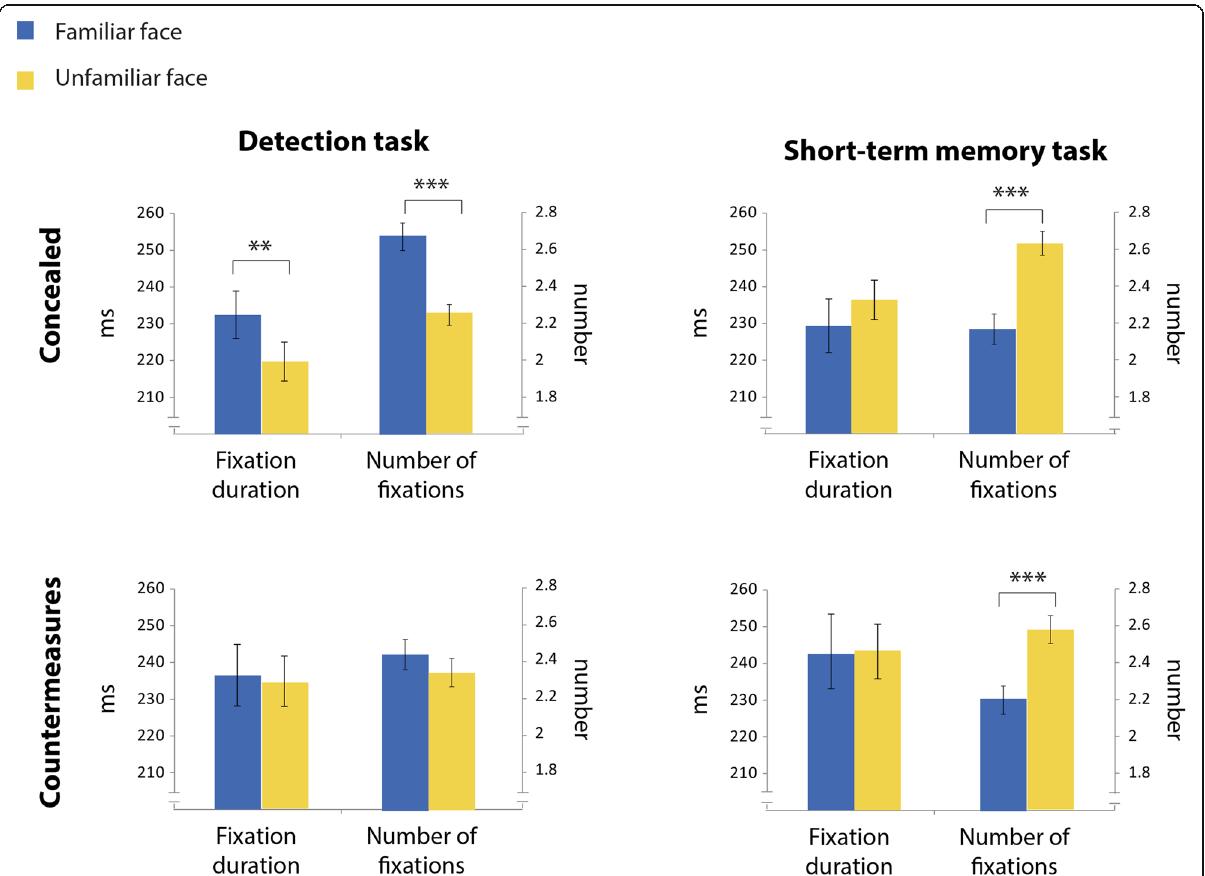
Fig. 4 Fixation analysis in the current study (left panel) and in the previous one (right panel). Each graph depicts the mean duration of fixations and their number, separately for familiar (blue) and unfamiliar (yellow) faces. Error bars indicate ± 1 standard error (SE). (** p value < 0.01, **** p value < 0.001 for paired t test comparisons between visits to familiar and unfamiliar